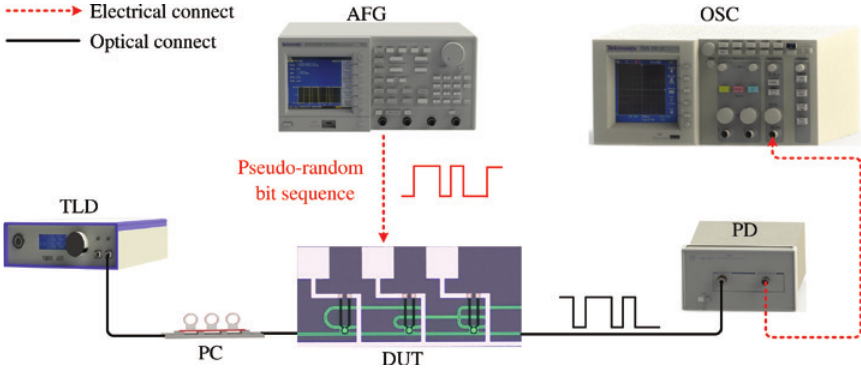
Figure 7: Experiment schematic for the dynamic response characterization of the device (TLD, tunable laser diode; PC, polarization